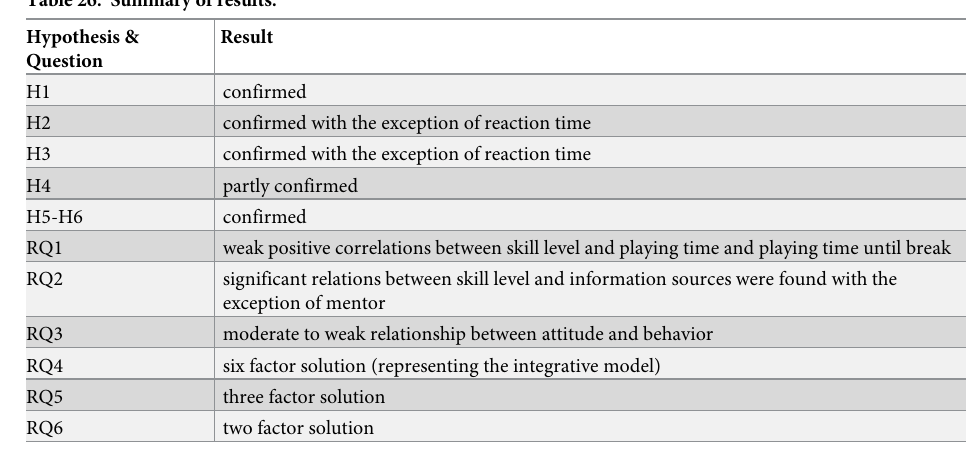
Table 26. Summary of results.